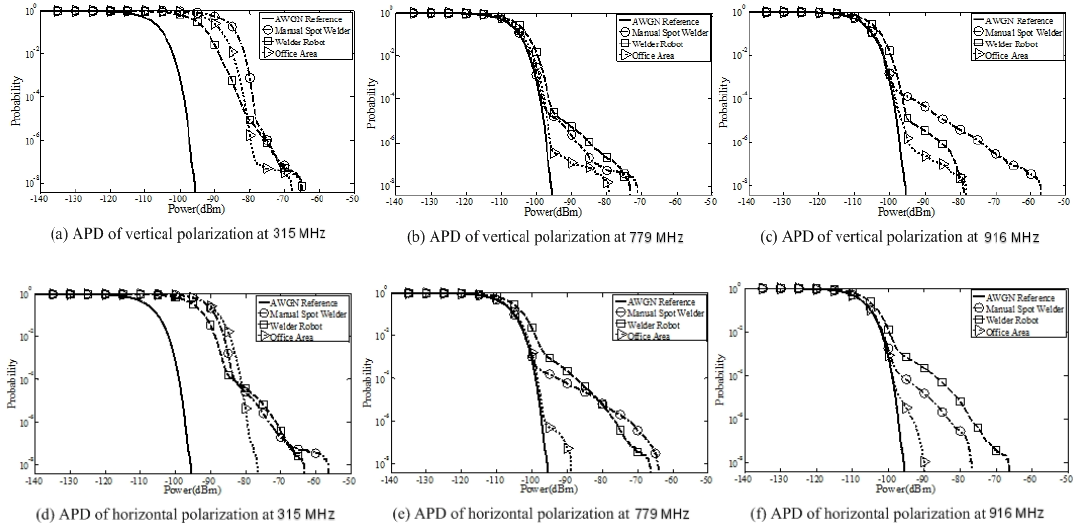
Figure 6. Amplitude probability distribution (APD) results. ( a ) APD of vertical polarization at 315 MHz; ( b ) APD of horizontal polarization at 315 MHz; ( c ) APD of vertical polarization at 779 MHz; ( d ) APD of horizontal polarization at 779 MHz; ( e ) APD of vertical polarization at 916 MHz; ( f ) APD of horizontal polarization at 916 MHz.